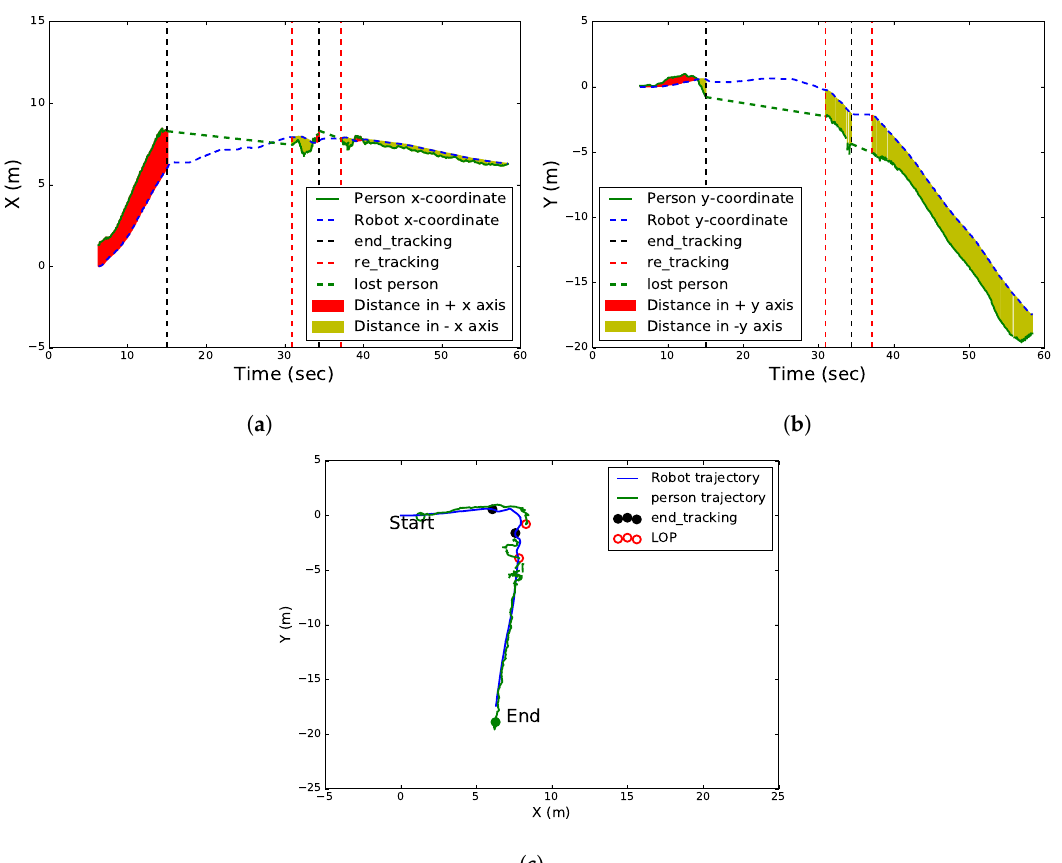
Figure 11. Robot and person movement trajectories in a realistic scenario for two states. ( a ) Robot and person trajectories along the x coordinate. ( b ) Robot and person trajectories along the y coordinate. ( c ) Robot and person trajectories in the world coordinate (2D) for two states.